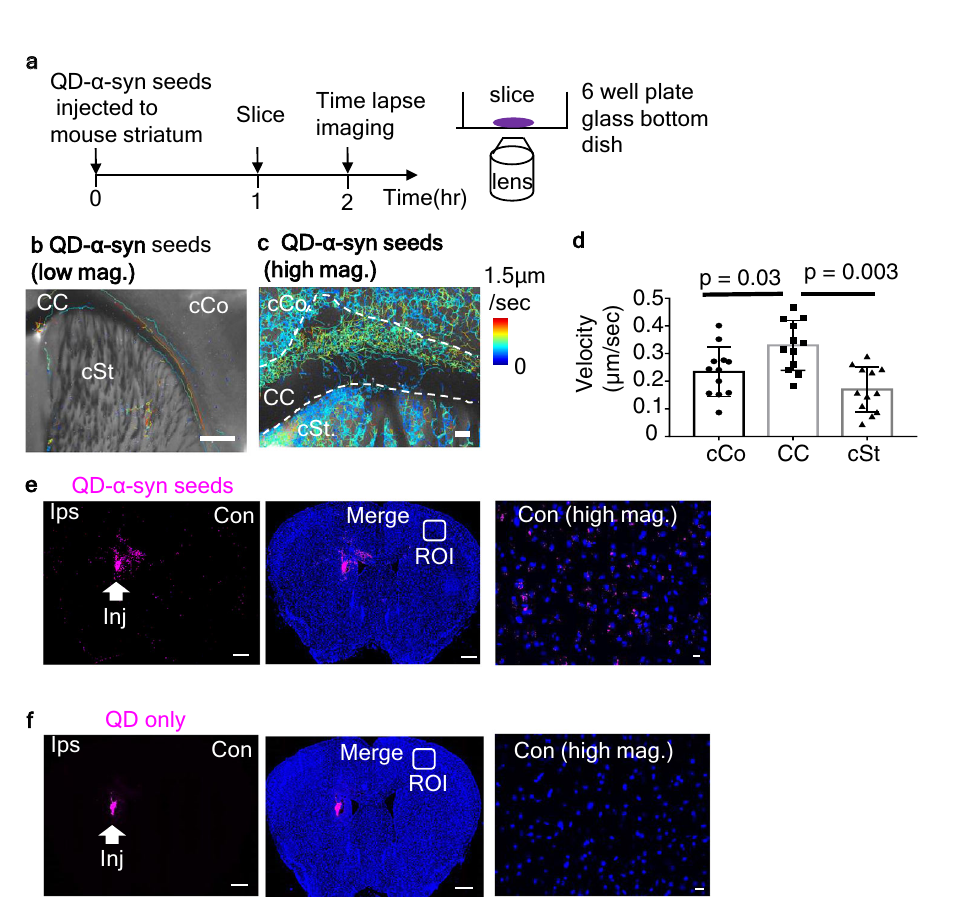
Fig. 2 QD- α -syn seed dynamics and localization in the brain slices. a Experimental procedures for time lapse imaging of slice. Slices were half submerged in culture medium and tightly attached at the bottom of six-well plate glass bottom dish. Recording was performed in humidi fi ed cultured box saturated with 95% O 2 /5% CO 2 . b Tracking of α -syn seeds (white dots) conducted by Image-J plug-in Trackmate. Velocity shown by line color. Bar: 500 μ m. c High magni fi cation of α -syn seed tracking. Color bar shows speeds. Bar: 50 μ m (see Supplemental video 1 for their dynamics). d Velocity of QD- α -syn seeds in each area of ( c ). e Fluorescence view of tissue sections (10 μ m thick) at 2 h after injection of QD- α -syn seed. f QD only was injected. Indicated squares in the contralateral hemisphere (middle panels) were magni fi ed (right panels) ( e , f ). Bar: 500 μ m (low mag.: left and middle panels), 10 μ m (high mag.: right